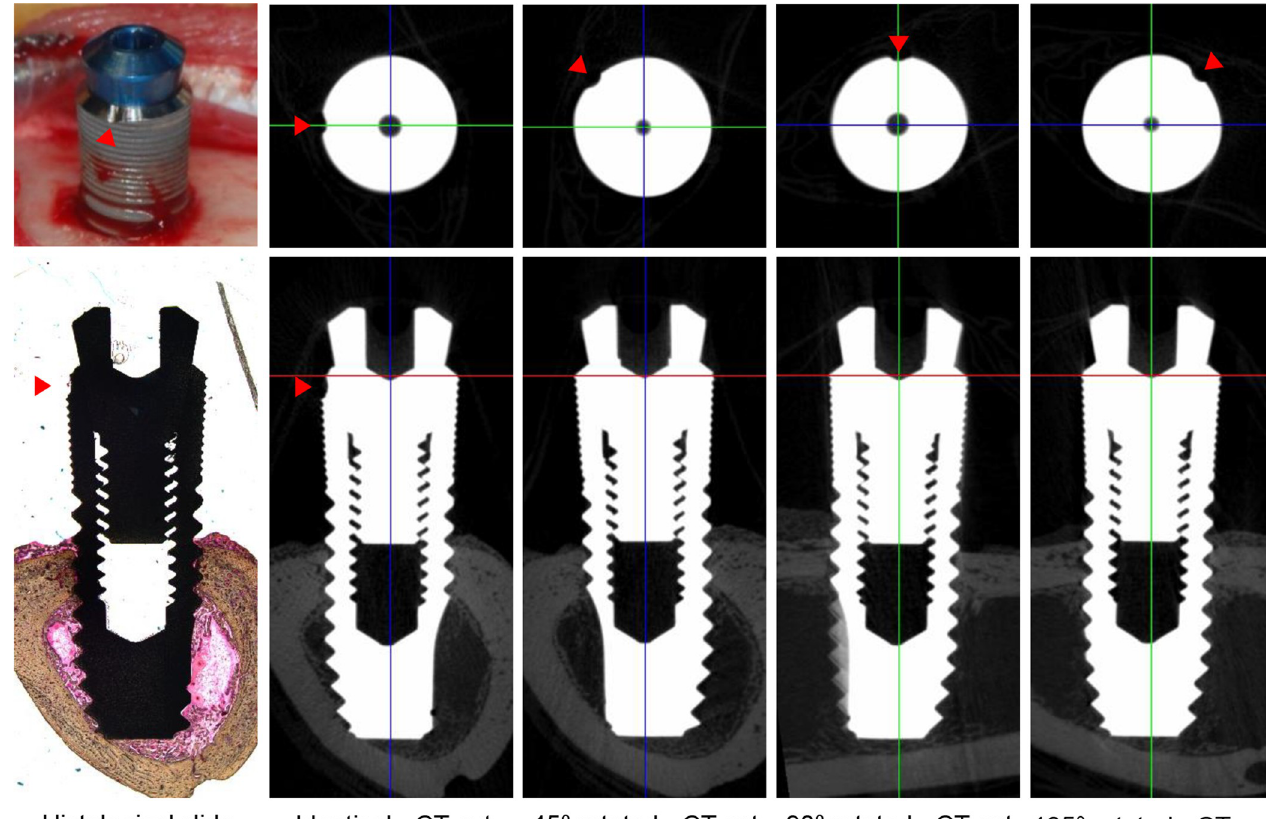
Fig 2. Two-dimensional micro-computed tomography ( μ CT) analysis of bone-implant sections. Representative 2D- μ CT images of the histological-identical section of an implant and 45˚, 90˚, and 135˚ rotations of the plane. The red arrowheads indicate the position of the marker notch on the implant.